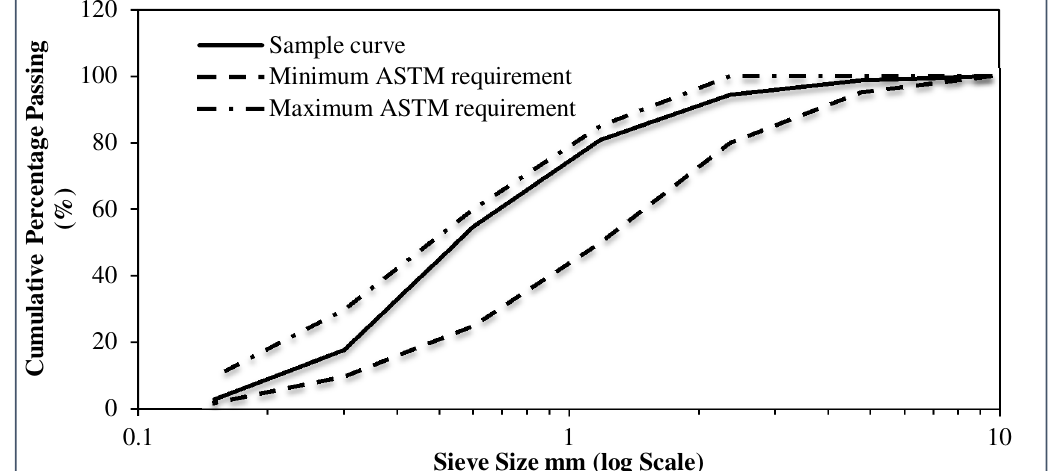
Fig. 2: Gradation curve for fine aggregate (Local Name Lawrencepur Sand)